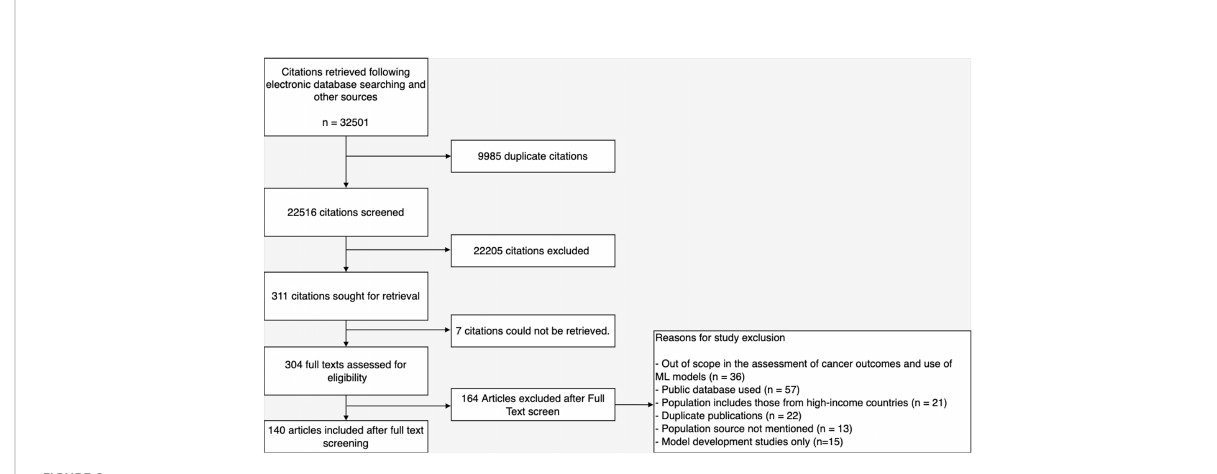
FIGURE 2 Flow chart of screening and study selection